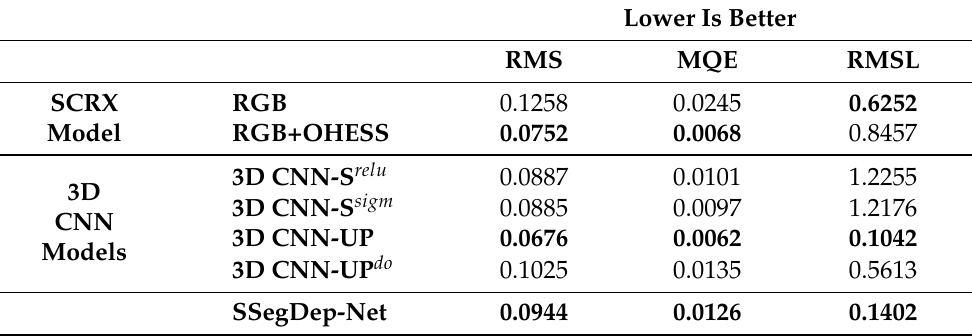
Table 2. Quantitative results using the RMS, MQE, and RMSL error metrics (see the Appendix A. 3D CNN-S relu uses ReLU in last layer, 3D CNN-S sigm uses sigmoid in the last layer, and 3D CNN-UP do adds